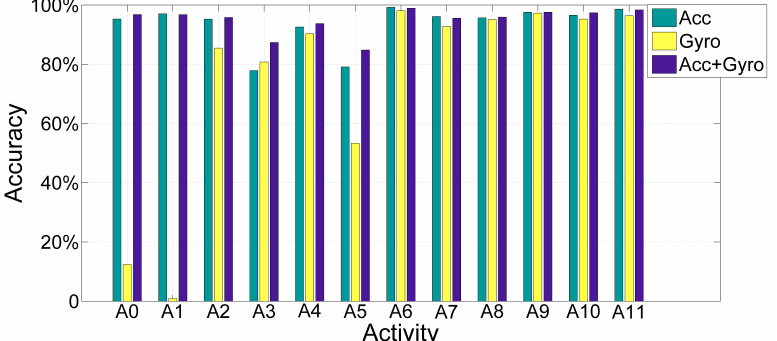
Figure 8. The performance changes of each activity recognition when adopting different